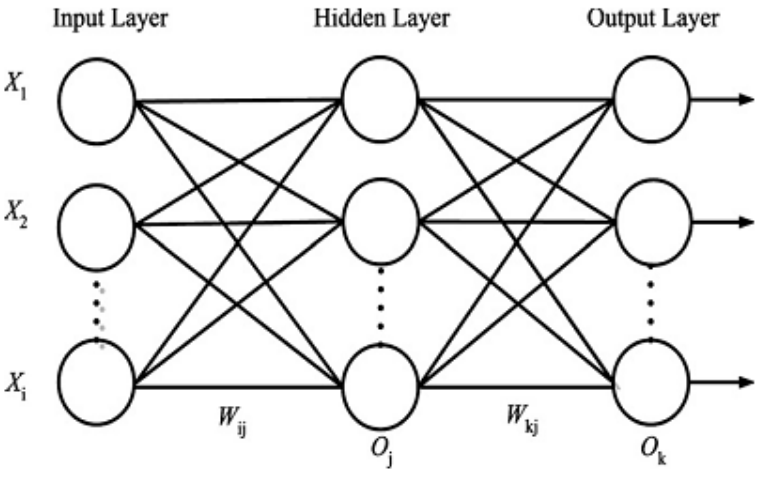
Figure 2. A fully connected multilayer feed-forward network with one hidden